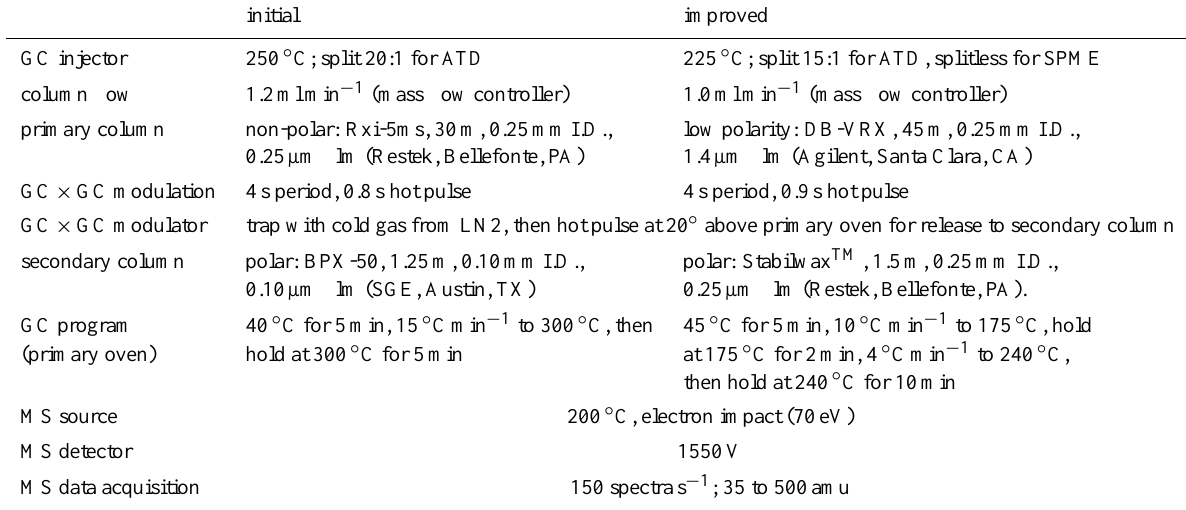
Table 3. Summary of GC × GC-TOFMS conditions used in VBOC